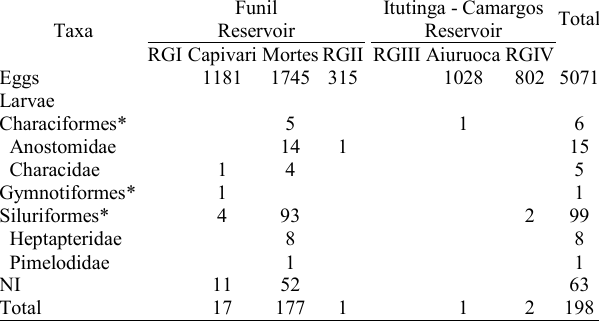
Table 2 . Number of eggs and larvae collected at each sampling site according to taxonomic group (RGI = rio Grande immediately downstream of the Funil Dam; RGII = Rio Grande immediately upstream of the Funil Reservoir; RGIII = rio Grande immediately downstream of the Itutinga Dam; RGIV = rio Grande immediately upstream of the Camargos Reservoir; NI = non-identified larvae). *Larvae identified by order. *NI = Not